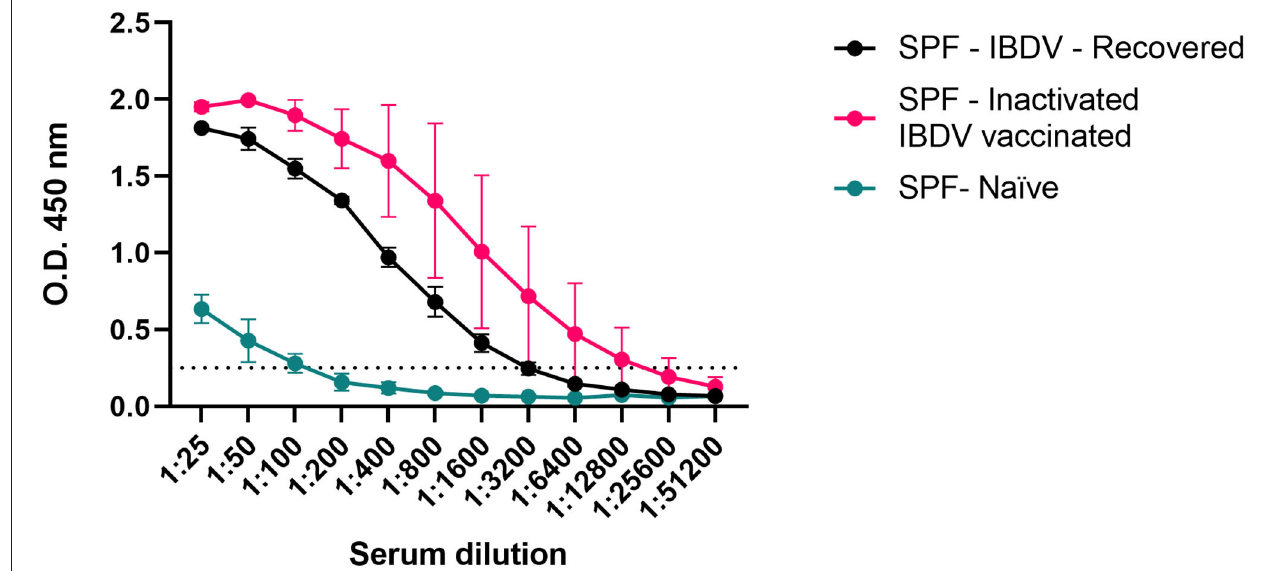
FIGURE 4 | Estimation of the analytical sensitivity of the His-VP3 ELISA. Mean O.D. 450 values of three individual sera obtained from experimentally infected (SPF-IBDV-recovered; black), inactivated IBDV vaccinated (SPF-inactivated IBDV vaccinated; pink), and naïve (SPF-Naïve; green) SPF chickens. Vertical bars: standard deviation. The positive threshold for His-VP3 ELISA is indicated with a dotted line (O.D. 450 = 0.250).